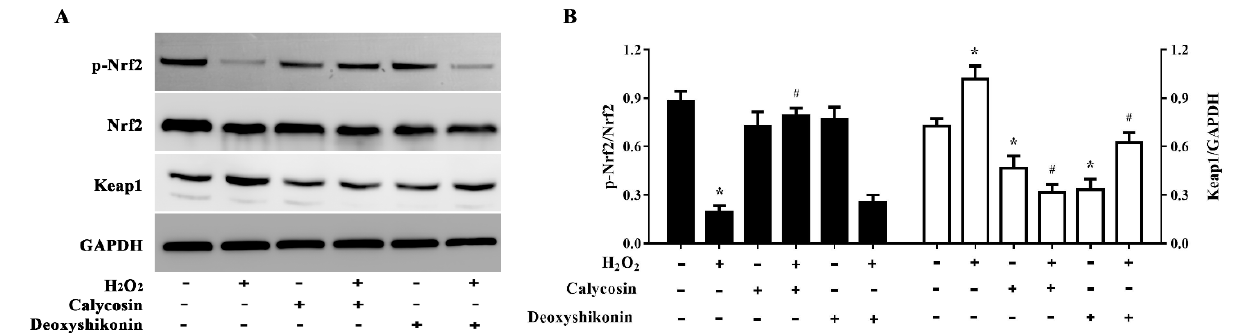
Figure 8. Effects of the hit compounds on the Nrf2-Keap1 pathway in IPEC-J2 cells. IPEC-J2 cells were pretreated, and not pretreated, with calycosin or deoxyshikonin for 24 h, then with 1000 μ M H 2 O 2 for 4 h. Nontreated cells served as a control. ( A ) Western blots of protein levels of Nrf2, p-Nrf2, and Keap1. ( B ) Quantitative analysis of Nrf2, p-Nrf2, and Keap1 protein levels. Data represent the mean ± SEM of three independent experiments. Differences between two groups were determined using Student’s t -tests. * p < 0.05 vs. nontreated control cells; # p < 0.05 vs. H 2 O 2 -treated cells.